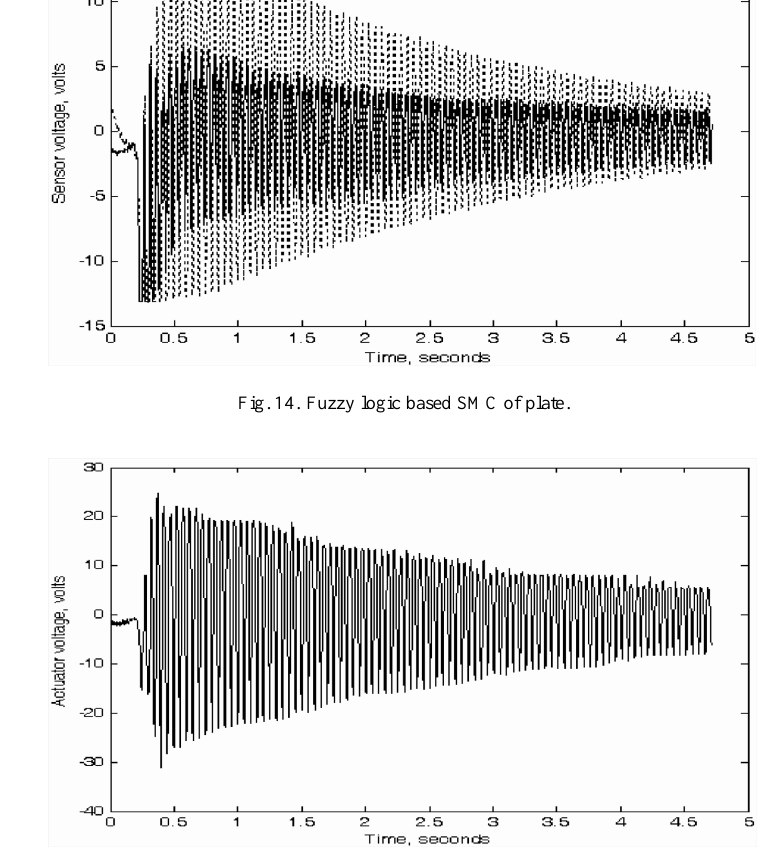
Fig. 15. Voltages applied on actuator when plate is controlled by fuzzy SMC.